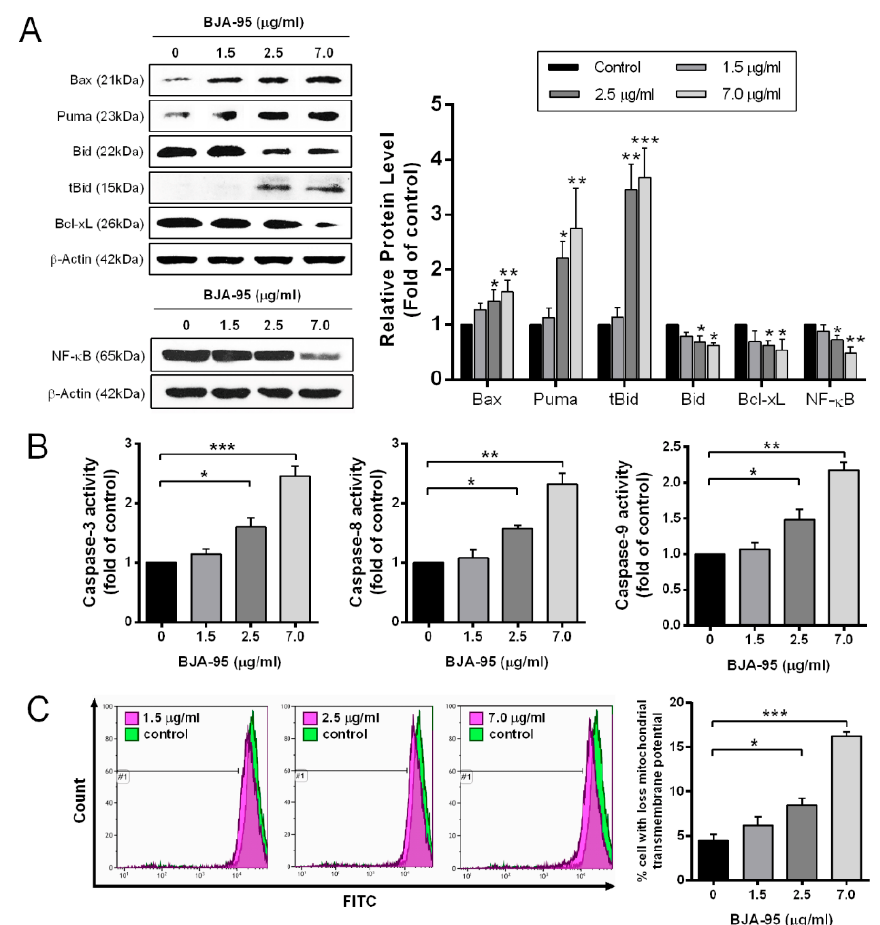
Figure 2. Apoptosis induction by BJA in CCA cells. KKU-213 cells were treated with indicated concentrations of BJA-95 for 24 h. Cells were stained with annexin V-fluorescein isothiocyanate and propidium iodide (annexin V-FITC/PI) and analyzed by flow cytometry. The bar graph presents the percentage of apoptotic cells. Results are shown as mean ± SD, n = 3. (***) p < 0.001 and (****) p < 0.0001 when compared with the control.